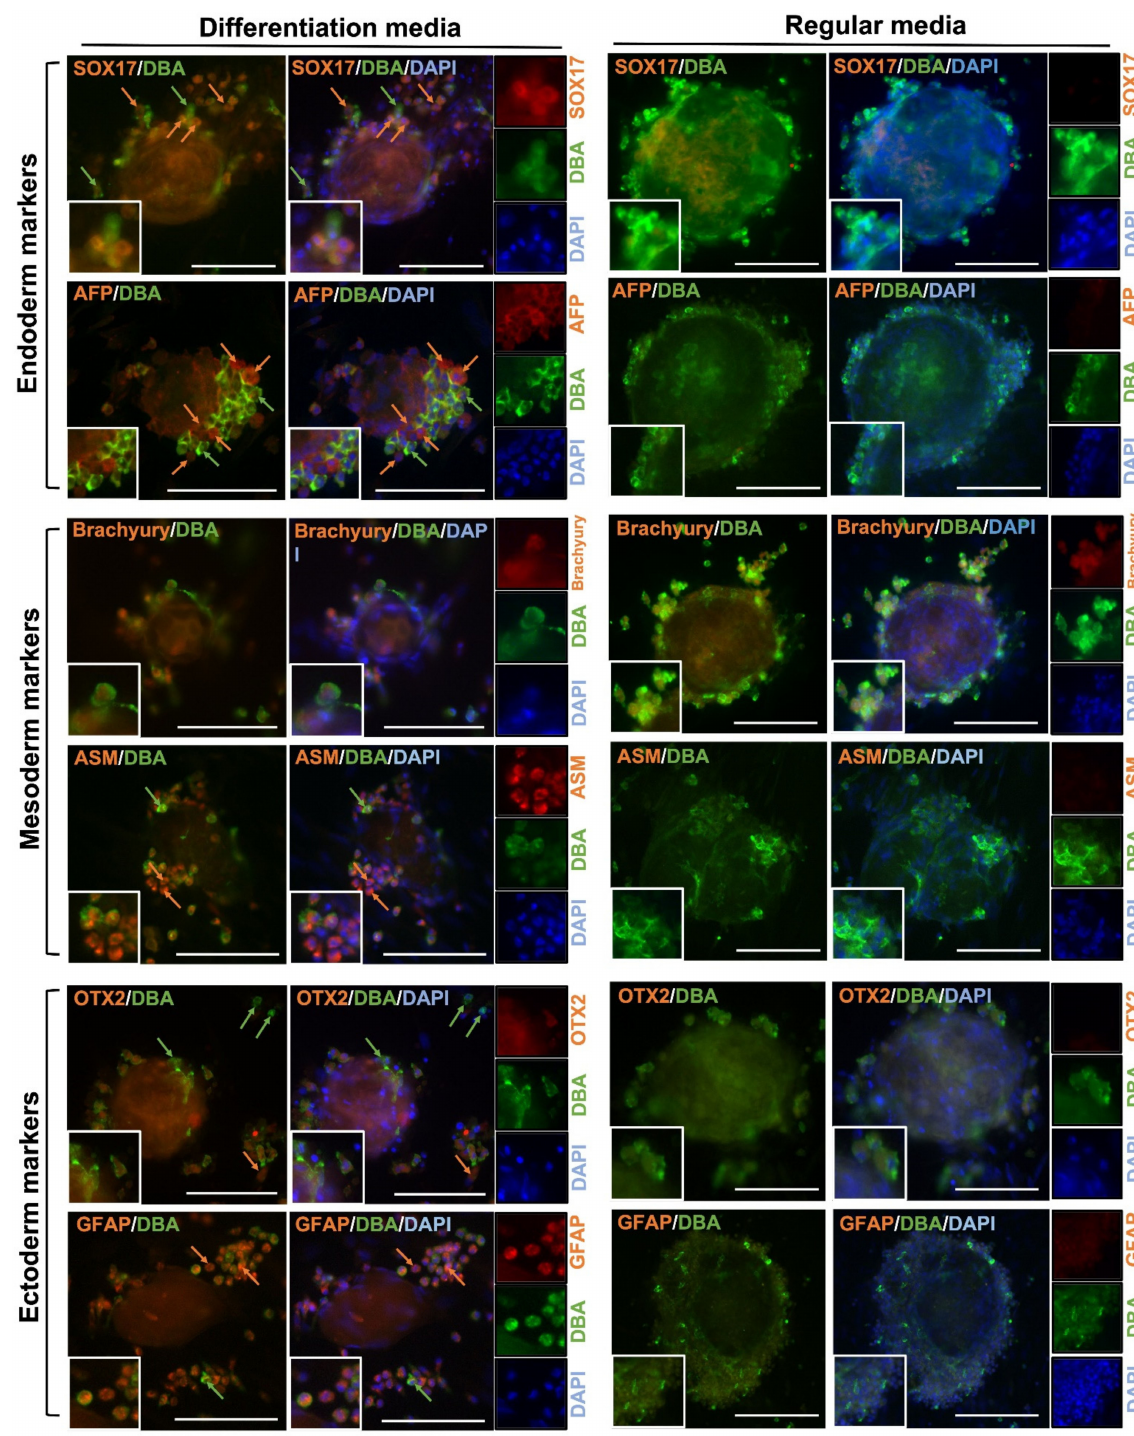
Figure 5. Expression of a gonocyte-specific marker (DBA) and markers of endoderm (SOX17 and AFP), mesoderm (Brachyury and ASM), and ectoderm (OTX2 and GFAP) by cultured gonocytes and their colonies in regular and differ- entiation media. Overall, gonocytes and embryoid body-like colonies (EBLCs) were positive for DBA. Many gonocytes showed strong expression of DBA (green arrows) but weak expression of lineage-specific markers. Other gonocytes showed strong expression of the lineage-specific markers (orange arrows) when cultured in corresponding media. EBLCs appeared positive for all three lineage differentiation markers. When cultured in regular media, gonocytes, and EBLCs were positive for DBA and Brachyury, but were negative for OTX2, SOX17, AFP, ASM, and GFAP. This may indicate that gonocytes in differentiation media are gradually converting into a new population of cells with similar biomolecular properties as cells of three germinal layer derivatives. Insets show higher magnification (Scale bar = 100 µ